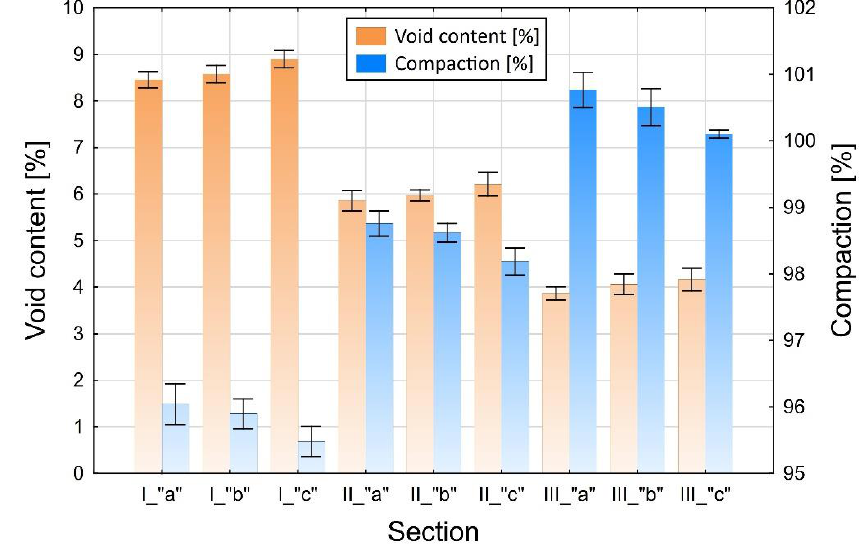
Figure 4. Compaction and air void content in the cores taken from the 8 cm thick binder course depending on the location. The zone and section designations are the same as in Figure 3.